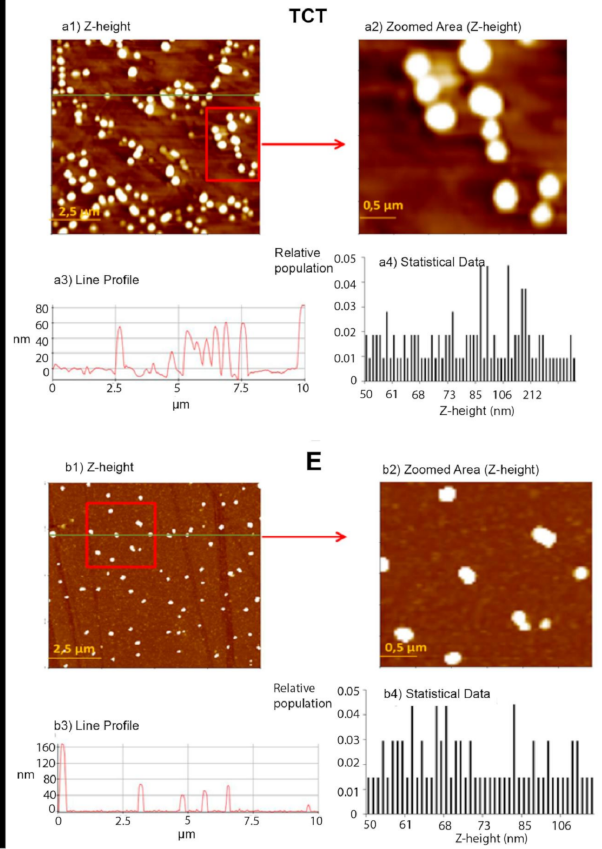
Figure 5. Representative images of EVs of TCT ( a ) and EVs of E ( b ) of T. cruzi Pan4 strain. ( a1 ) Z- height image of EVs of TCT; ( a2 ) zoomed area from image a1; ( a3 ) line profile for the green line in the topography image (Z-height is in the range 40–80 nm) and ( a4 ) statistical data of the relative frequency of the Z-height (nm). ( b1 ) Z-height image of EVs of E; ( b2 ) zoomed area from image b1; ( b3 ) line profile for the green line in the topography image (Z-height is in the range 40–160 nm) and ( b4 ) statistical data of the relative frequency of the Z-height